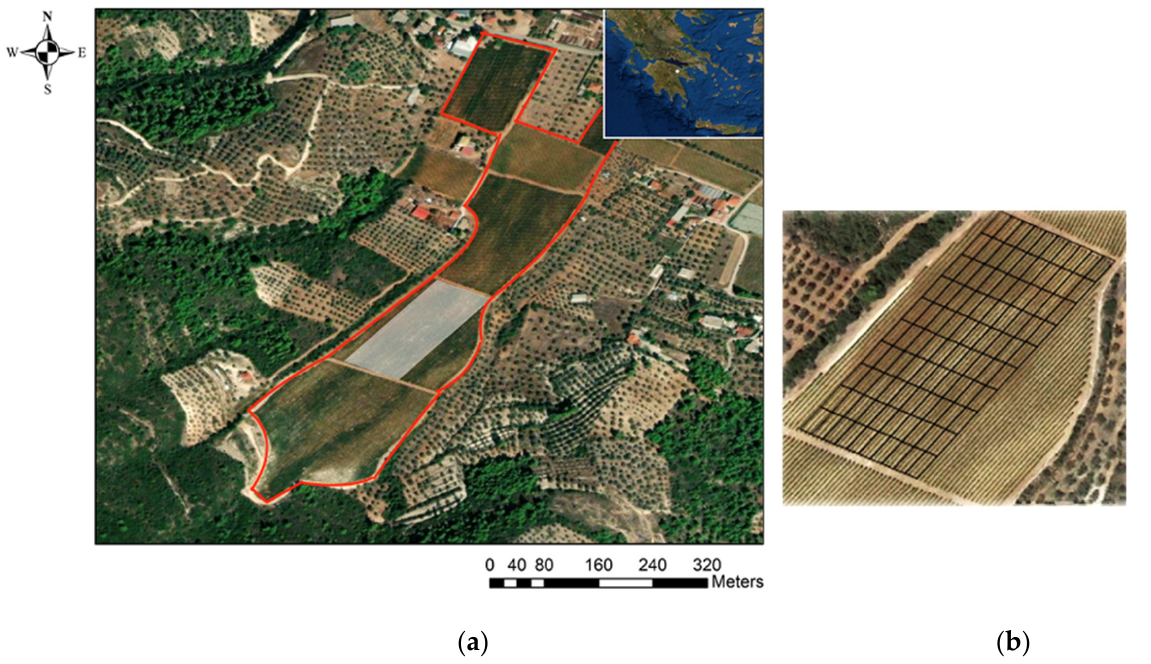
Figure 3. A satellite image showing ( a ) the national and local position of the commercial vineyard and ( b ) the 100-cell grid constructed parallel to the trellis